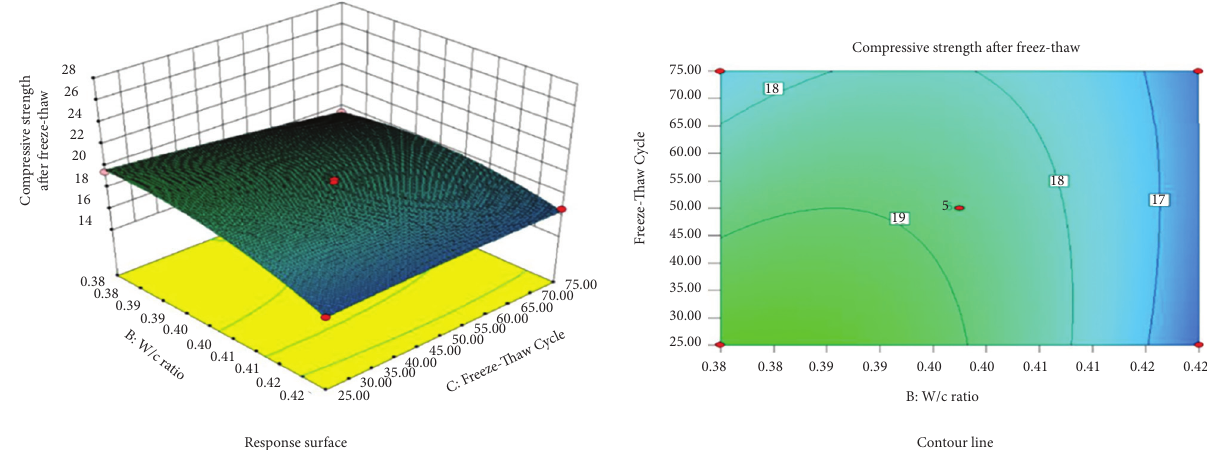
Figure 7: Effect of w/c ratio B and freezing-thawing times C on compressive strength after